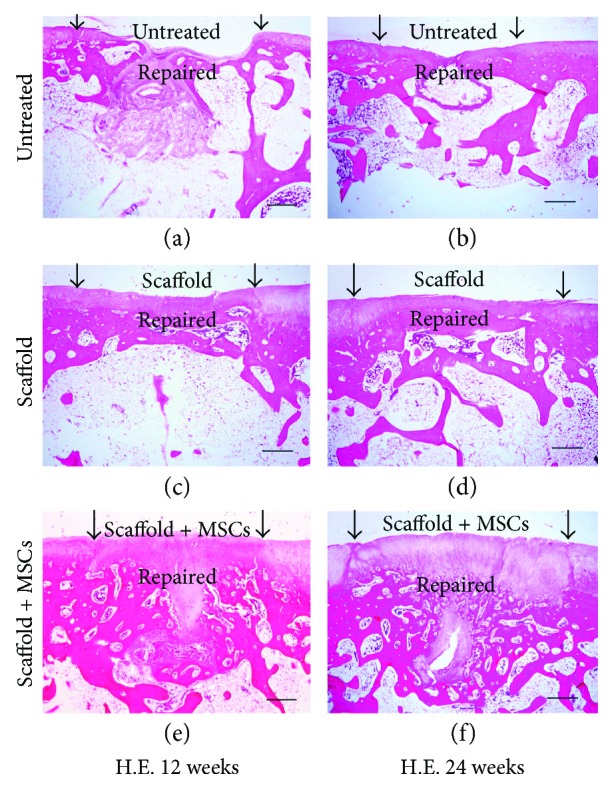
H.E. staining of repaired cartilage at 12 and 24 weeks postimplantation. (a) and (b) At 12 weeks postoperation, the defect area in the untreated group was partially filled with fibrotic tissue. No evident cartilage or subchondral bone regeneration was evident. Moreover, no regeneration was evident at 24 weeks; only fibrous tissue was present. (c) and (d) At 12 weeks postoperation, the defect region was filled with repaired tissue and the boundary exhibited continuous integration with healthy cartilage. The repaired cartilage was clearly thinner than native cartilage. At 24 weeks postimplantation, no further obvious cartilage regeneration was apparent; however, subchondral bone regeneration had progressed further. (e) and (f) At 12 weeks postoperation in the cell-loaded scaffold group, the cartilage defect was filled with regenerated cartilage and subchondral bone and the boundary exhibited continuous integration with healthy cartilage. The thickness of the repaired cartilage was close to that of native cartilage. At 24 weeks postimplantation, cartilage and subchondral bone regeneration were further enhanced and the tissues were similar to native tissues (bars: 50 μm).